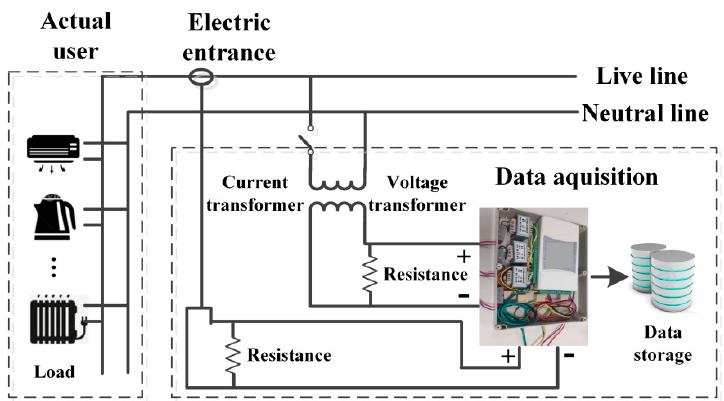
Figure 5. Schematic diagram of the experimental system.